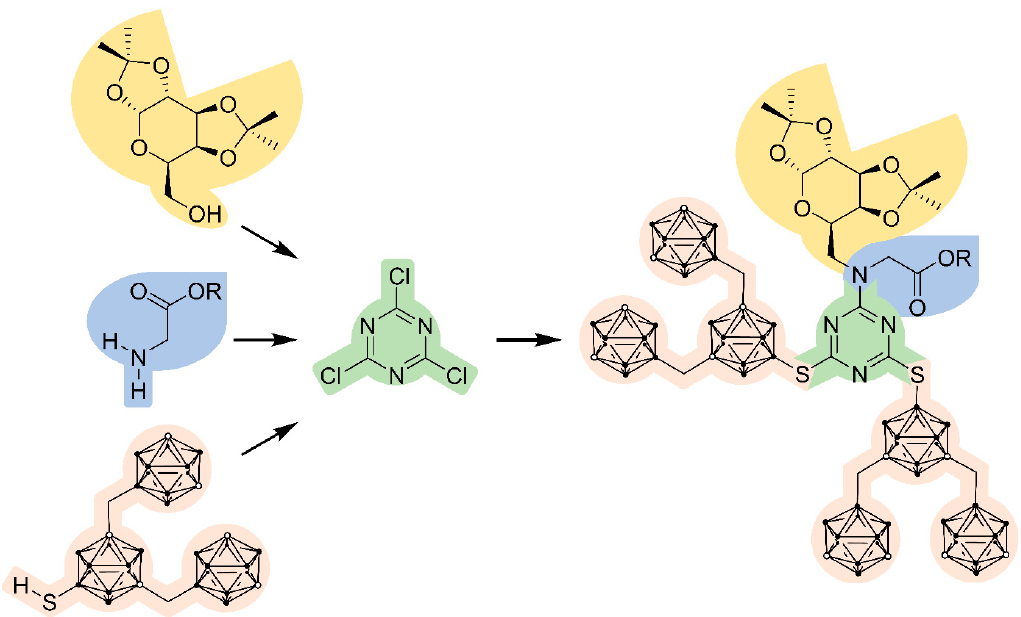
Figure 1. Illustration of the modular system incorporating an α - D -galactopyranosyl moiety (yellow), protected glycine (blue), a tris-cluster derivative of 9-mercapto-1,7-dicarba- closo -dodecaborane(12) (pale red) and cyanuric chloride (green) as core; R = tert -butyl.